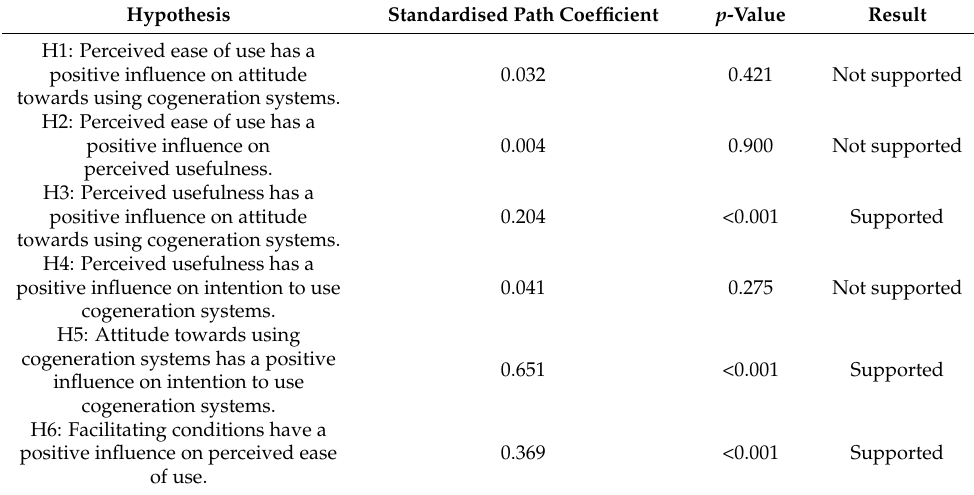
Table 7. Hypothesis-testing